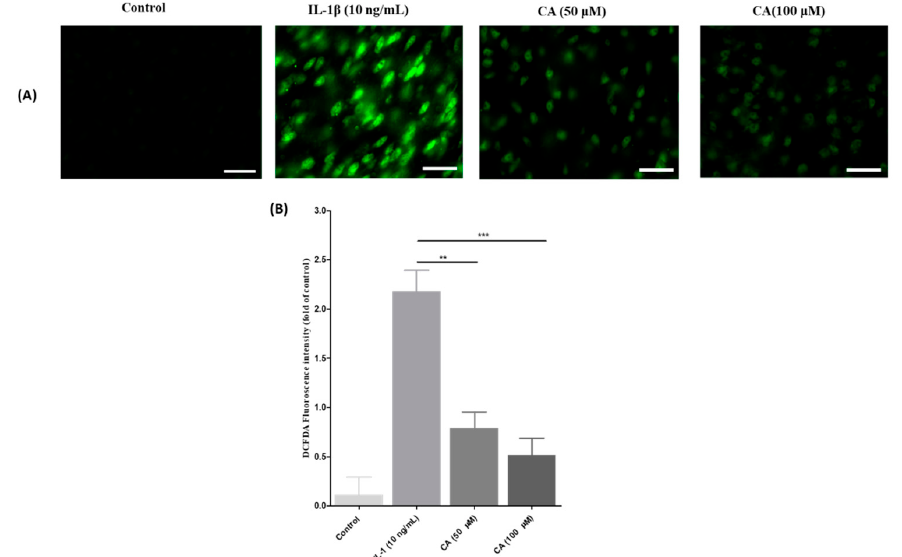
Figure 11. The ROS inhibition capacity of CA was checked using DCFDA assay. ( A ) Microscopic analysis of ROS generation in the FLS cells treated with IL-1 β (10 ng/mL), and CA (50 and 100 μ M), scale bar = 100 μ M. ( B ) Quantitative assessment of DCFDA fluorescence in FLS cells. Data expressed as mean ± S.D., ** p < 0.01, and *** p < 0.001.